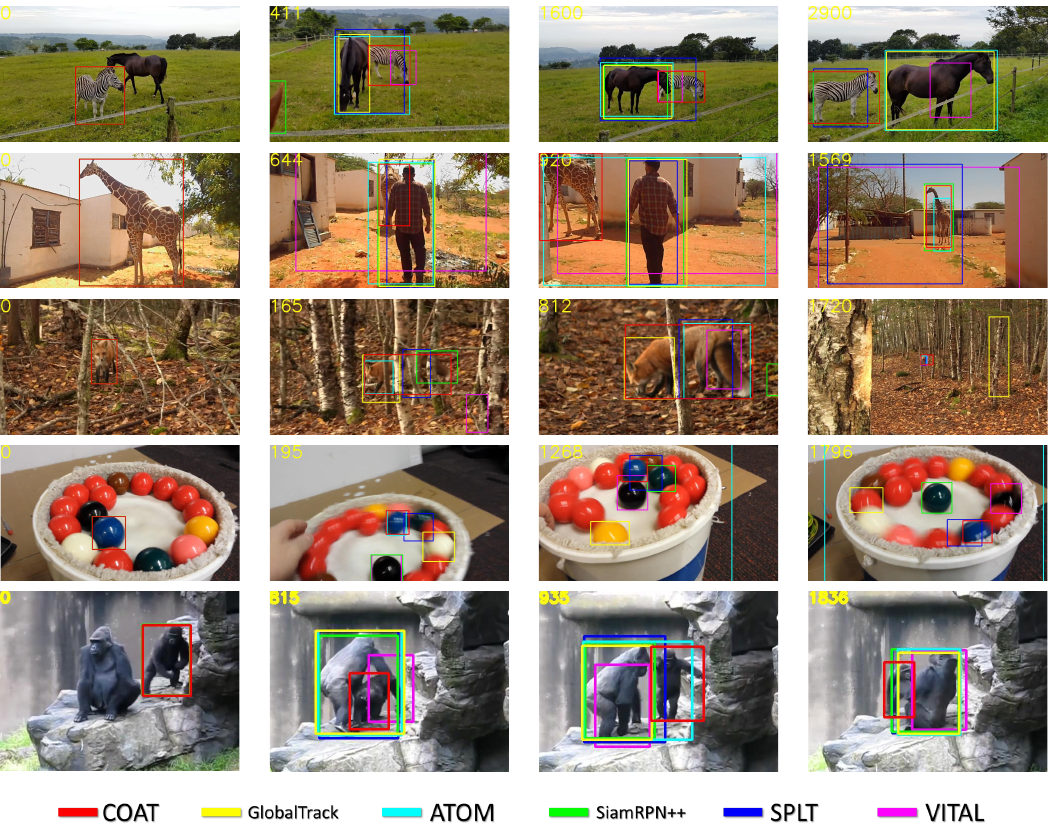
Figure 6. Qualitative results on the LaSOT test set. Tracking results are for sequences zebra-17, giraffe-10, fox-5, pool-12, and gorilla-9 . Best viewed on a high resolution